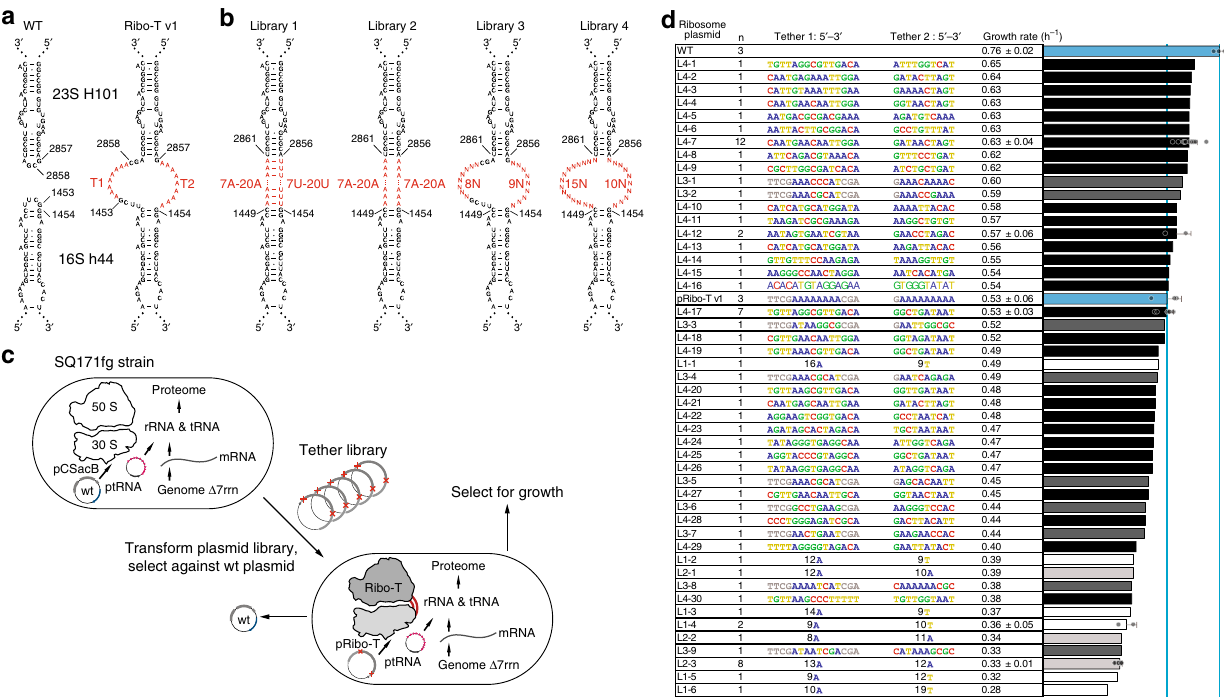
Fig. 2 Optimizing tether sequence improves performance. a Wild-type 23S rRNA helix 101 and 16S rRNA helix 44 are connected to create Ribo-T with 9A for 5 ′ tether, T1, and 8A for 3 ′ tether, T2. b Library 1: paired 5 ′ tether T1 poly A from 7 – 20 nucleotides, with 3 ′ tether T2 poly T from 7 – 20 nucleotides. Library 2: unpaired polyA on both T1 and T2, ranging in 7 – 20 nucleotides long. Library 3: randomized T1 (8N) and T2 (9N) keeping residues of opened H101 and h44 apex loops. Library 4: randomized apex-to-apex T1 (15N) and T2 (10N) of tether. c Selection scheme for improved tethers. Strains lacking genomic copies of rRNA operons ( Δ 7rrn) are transformed with plasmid-based Ribo-T tether libraries, and the wild-type pCSacB plasmid (wt) is removed. d Tether sequences and growth rates of analyzed colonies. Error bars = 1SD of noted independent colonies, n. The top 15 Ribo-T design winners (L4-1 through L4- 13) were co-cultured and passaged for 3 days. Between each passage, the bulk culture populations were sequenced and analyzed. Source data for d can